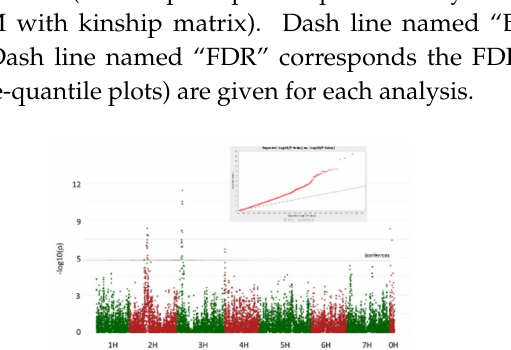
Figure A1. Manhatten plot with QQ-plot for GLM model for first bicomponent data.